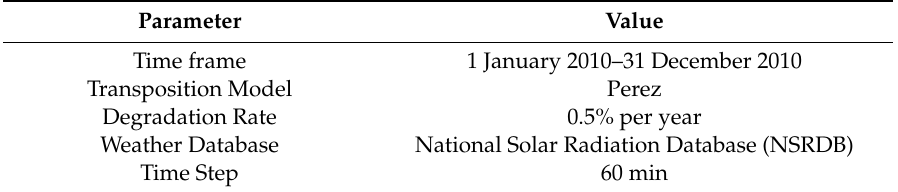
Table A3. Simulation settings for the PVS system dispatch model in Plant Predict.